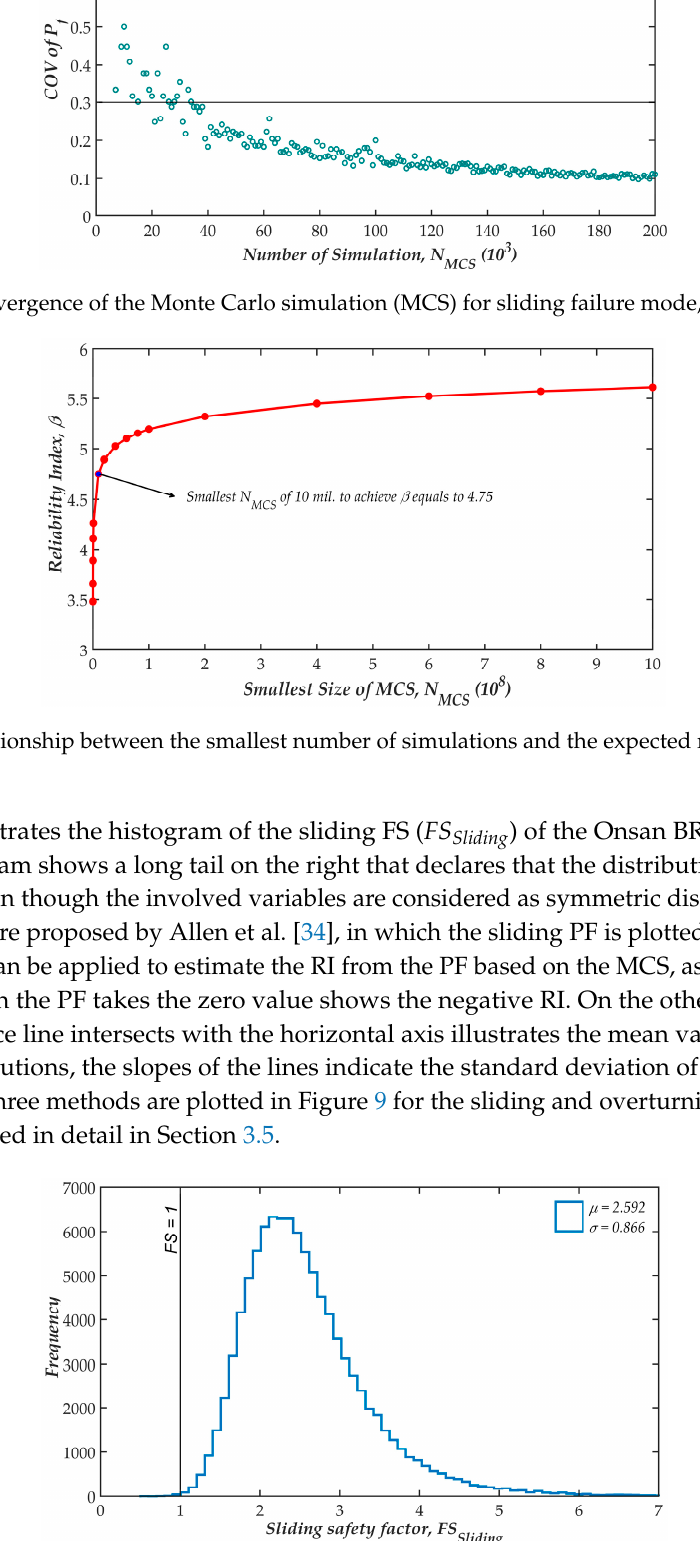
Figure 8. Cumulative density of the sliding performance function (PF) in the standard normal space. Figure 9. Reliability indices for sliding and overturning failure modes (sorted by β Sliding ).